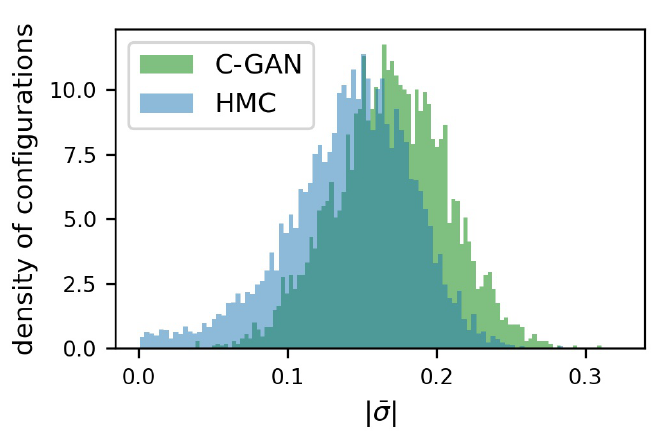
Figure 19: Ablation for log transformation: Histogram of | ¯ σ | at λ = 1.5 ∈ Λ without log transformation.